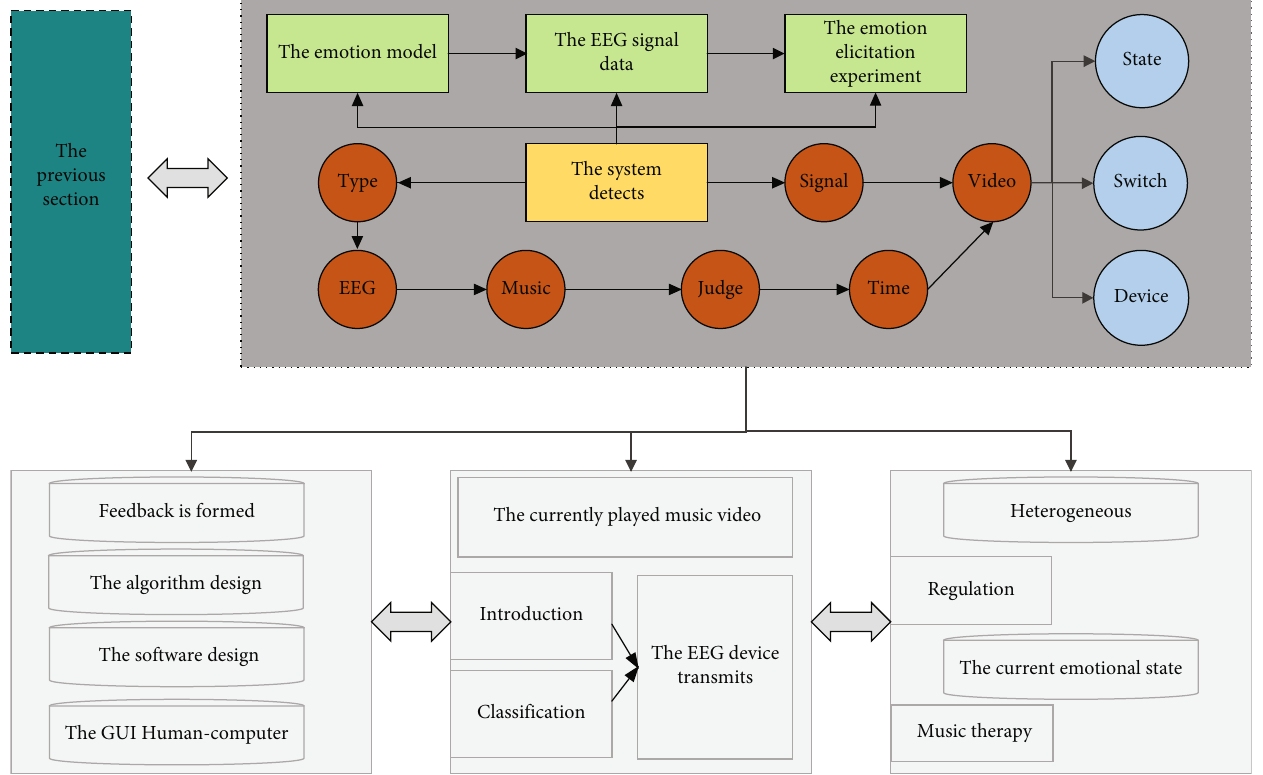
Figure 4: Flowchart of the system based on piano performance to alleviate psychological trauma of people with psychological isolation